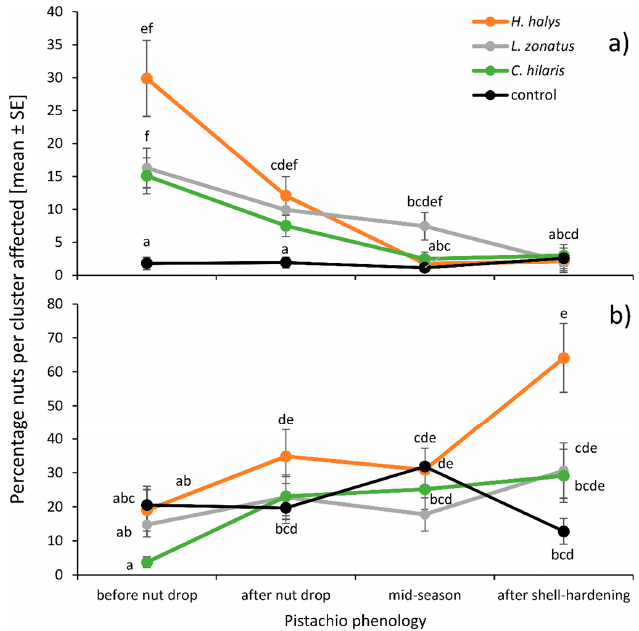
Figure 2. Interaction between insect treatment and pistachio phenology for ( a ) epicarp lesions immediately after insect exposure ‘el exp’ and ( b ) epicarp lesions during harvest time ‘el harv’. Di ff erent letters indicate significant di ff erences (generalized linear mixed model (GLMM), Tukey-adjusted mean